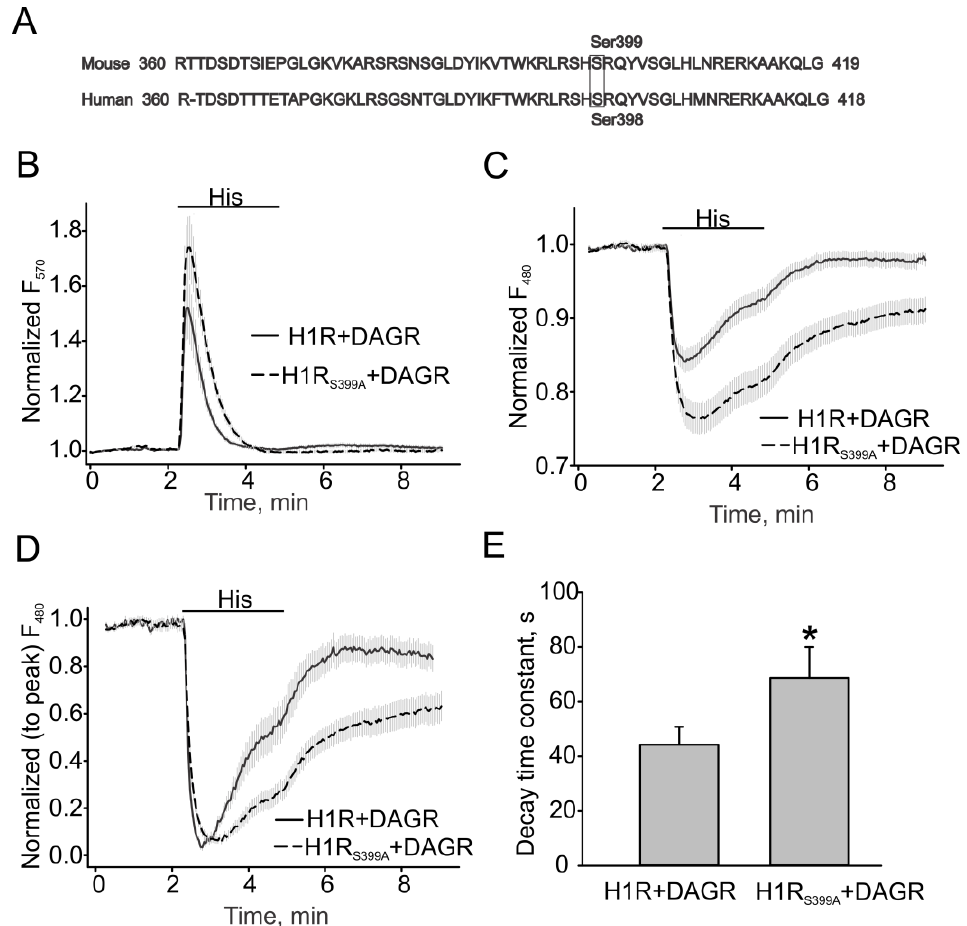
-expressing HEK S399A